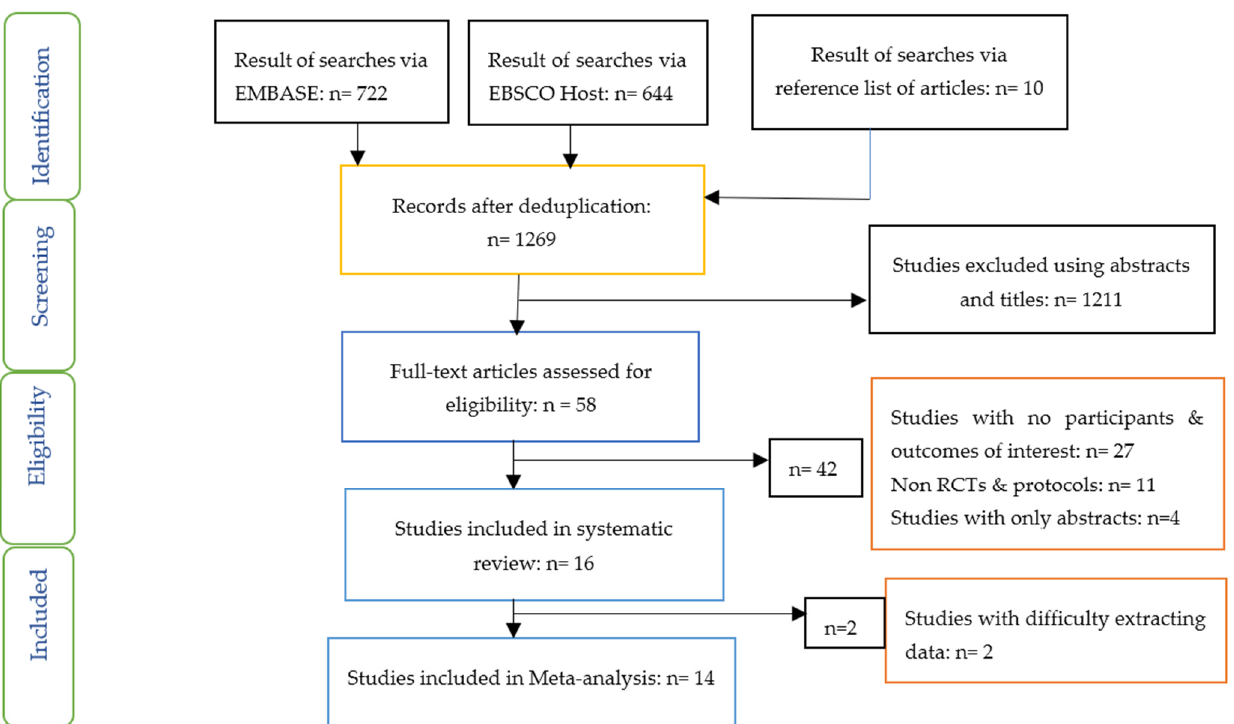
Figure 1. PRISMA flow chart on selection and inclusion of studies.